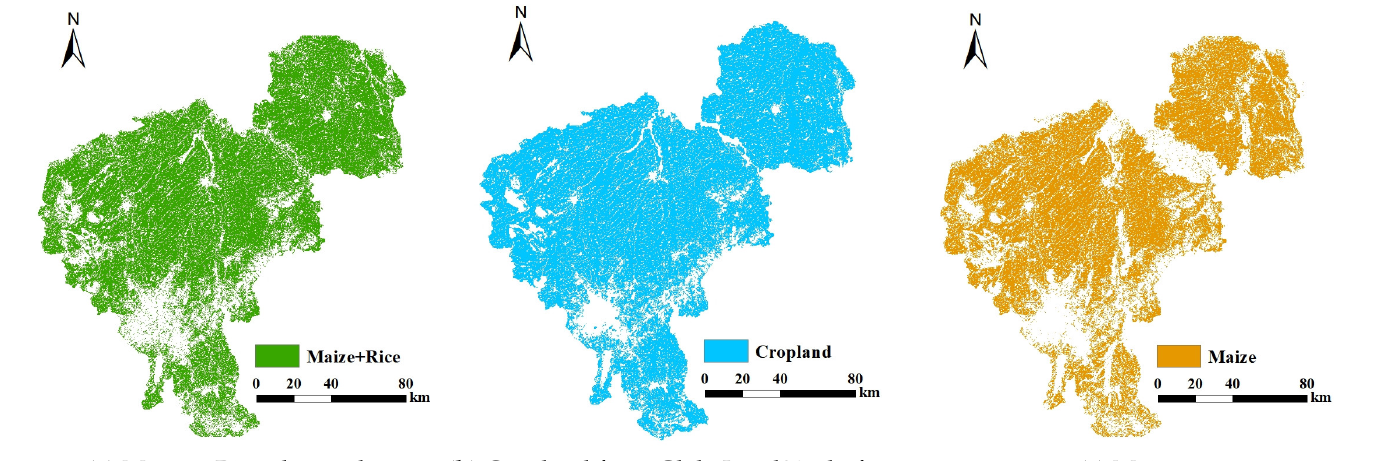
Figure 3. Crop patterns and cropland in Changchun area: ( a ) maize and rice obtained by decision tree classification; ( b ) cropland data in 2020 from the GlobeLand30 platform; ( c ) maize mapping by decision tree classification.